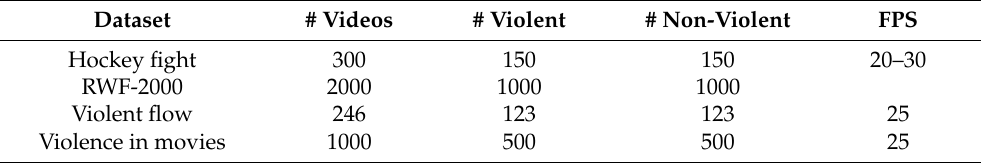
Table 1. Statistical details of the datasets used to analyze the performance of the proposed VD